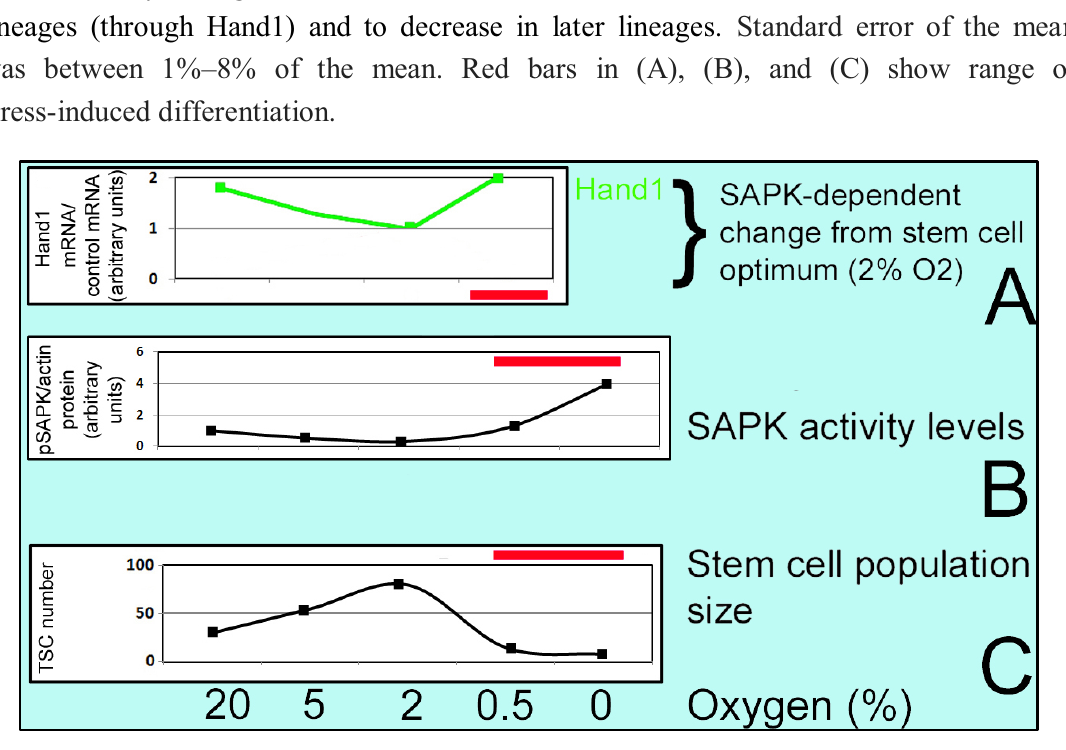
Figure 4. U shaped curve for prioritized differentiation. At 2% O2, Cell accumulation rate is highest and SAPK activity is lowest. At 0 (cid:177) 0.5% O2, the accumulation rate is lowest and SAPK activity is highest. As O2 moves from 2%, SAPK leads to increase in